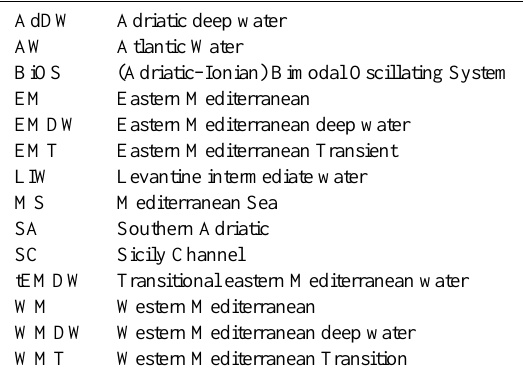
Table A1. List of